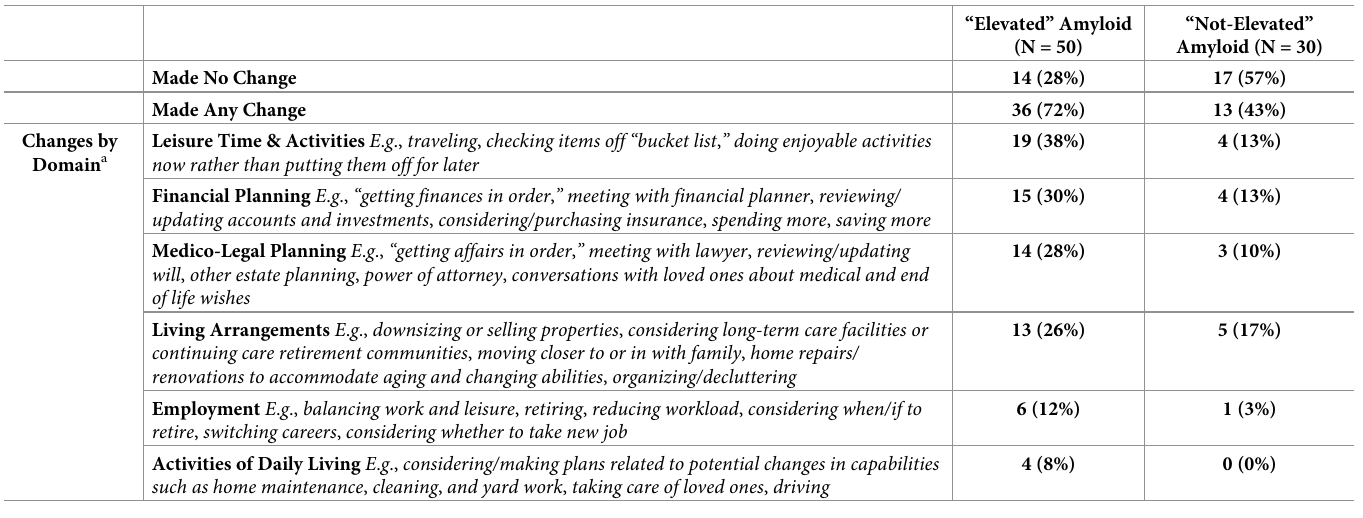
Table 4. Future planning: Material derived from responses to the questions: “How did learning your result change how you feel about your future? Are you chang- ing or reassessing any plans in your life since learning the